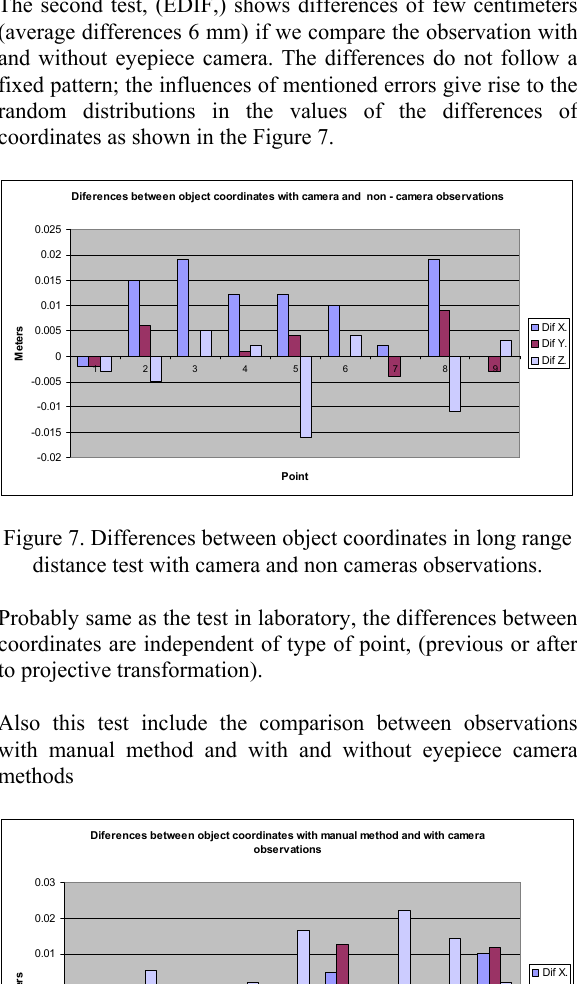
Figure 9. Differences between object coordinates in long range distance test with camera and manual